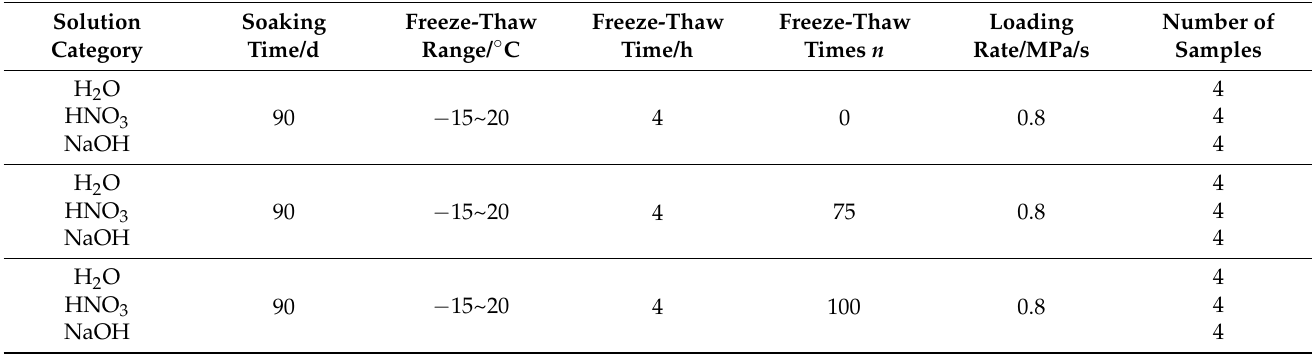
Table 1. Uniaxial compression test scheme of granite with different chemical solutions and freeze- thaw cycles.